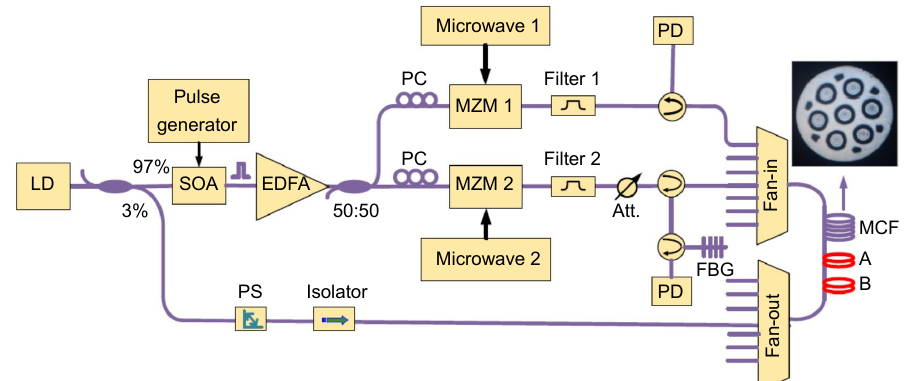
Fig. 17 | Experimental setup of the MCF based SDM hybrid BOTDA and φ -OTDR sensing system. LD: Laser diode; PC: polarization con- troller; SOA: semiconductor optical amplifier; MZM: Mach-Zehnder modulator; EDFA: erbium-doped fiber amplifier; PS: polarization switch; Att.: attenuator; PD: photodetector; Fan-in: fan-in coupler; Fan-out: fan-out coupler. Figure reproduced from ref. 67 , Optical Society of